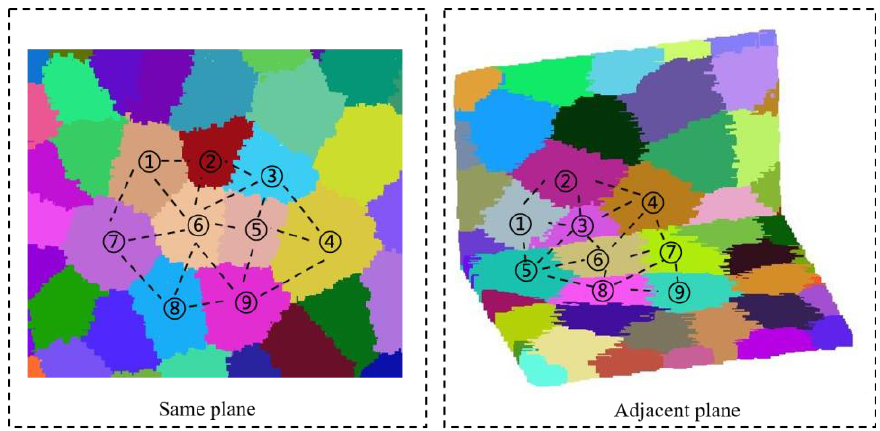
Figure 2. Schematic diagram of the adjacency relationships between voxels. Left: in the plane; Right: across a boundary.